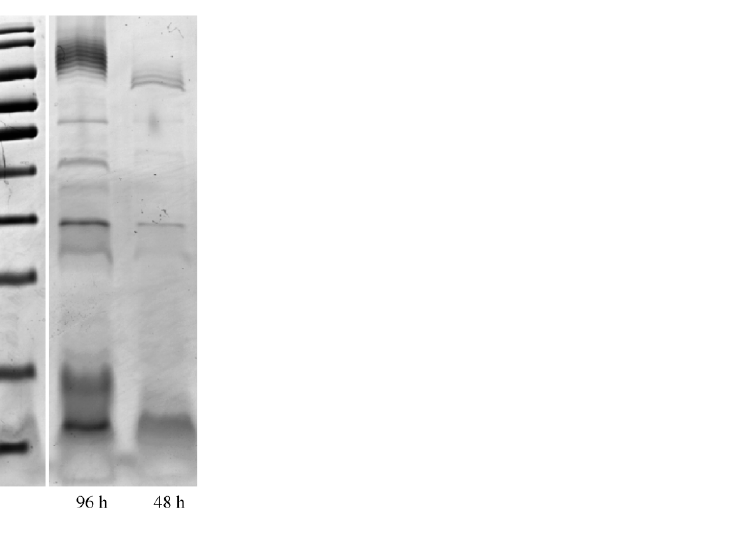
Figure 1. Results of fermentation supernatant protein after 48 h and 96 h fermentation.